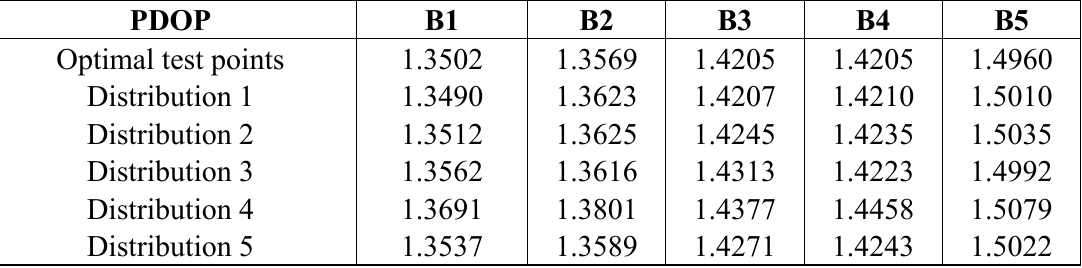
Table 1. PDOP values in the beacons’ location (B1 to B5) for the different distributions of the unknown test points around the optimal test points.